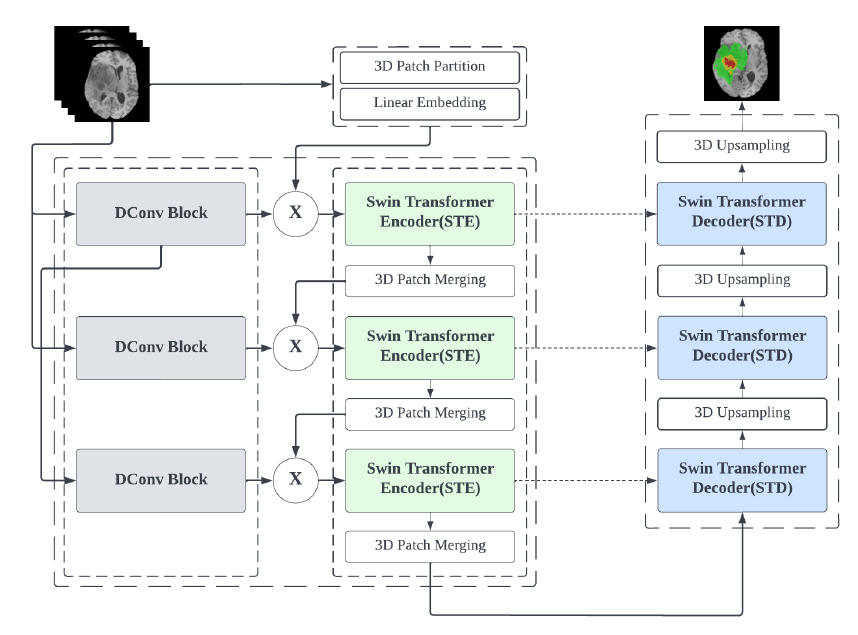
Figure 1. Overall network framework